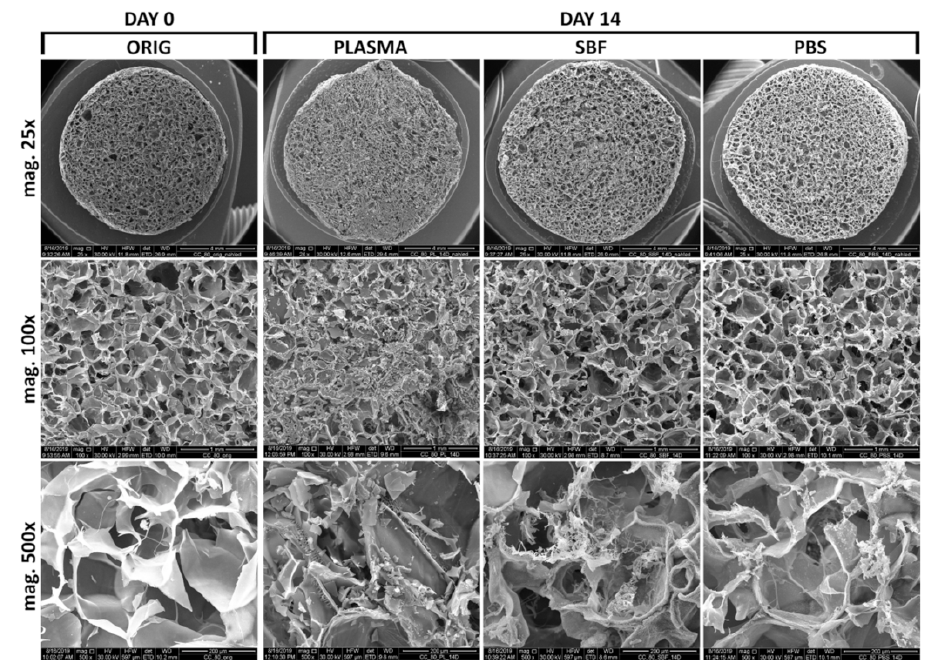
Figure 2. SEM images of the original collagen scaffolds and those immersed in human blood plasma, SBF, and PBS for 14 days.